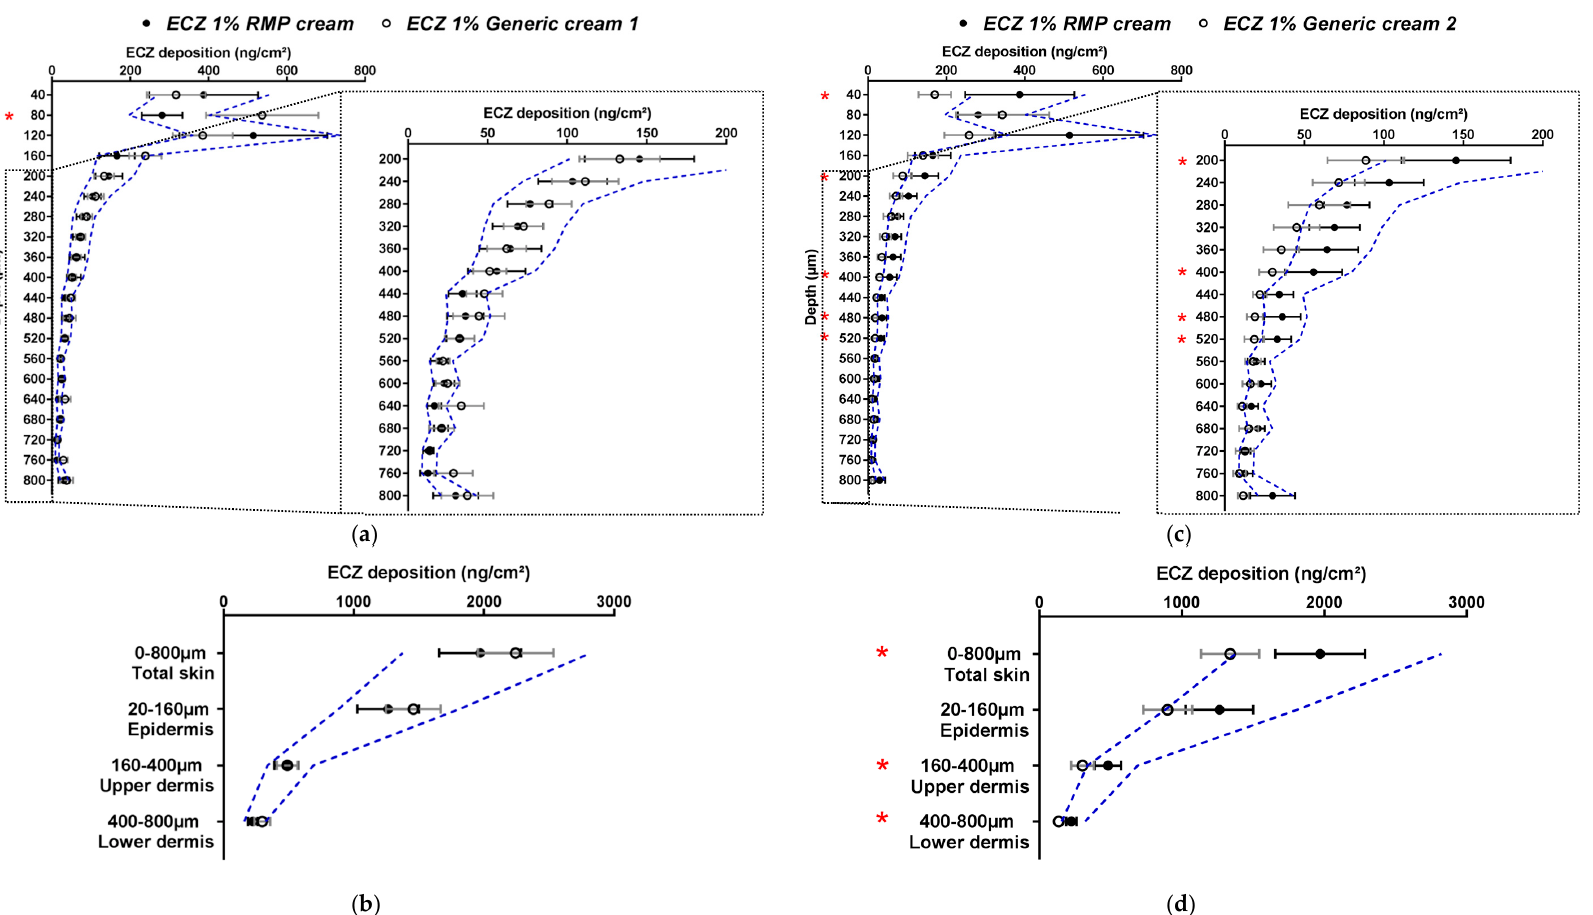
Figure 2. Cutaneous biodistribution profile of ECZ: ( a ) in porcine skin lamellae (2 × 20 µm + 19 × 40 µm) to 800 µm (full depth) and ( b ) as a function of position in the anatomical regions of the skin (epidermis, upper and lower dermis) and in total skin. Tested groups: reference medical product (ECZ 1% RMP cream) ( ) and non-bioequivalent “negative control” (ECZ 1% ethanolic solution) ( ). (Mean ± CI 90% ; n = 12 and n = 6, respectively). Intervals of acceptance criteria were calculated based on the mean ECZ deposition from the RMP; ( ) interval of 80.00–125.00% and ( ) interval of 69.84–143.19%. P -values were calculated using a Student’s t test; statistically significant differences are denoted by asterisks (* p < 0.05; ** p < 0.005; *** p < 0.0005; **** p < 0.00005).